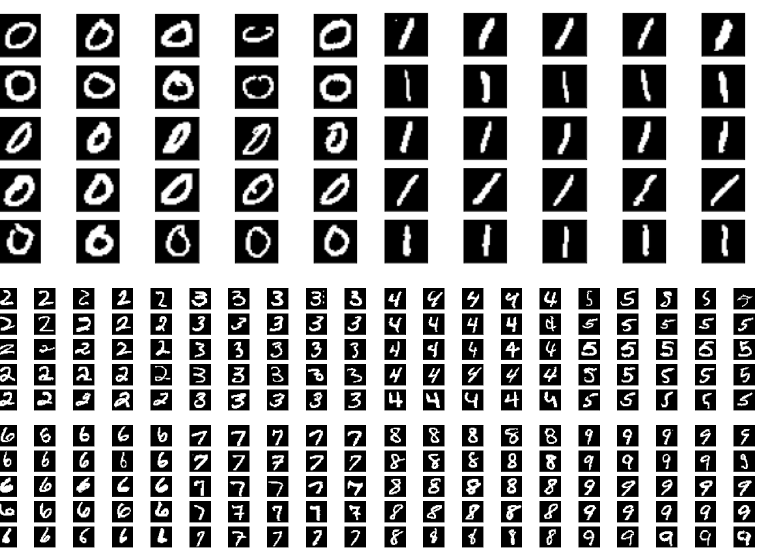
Figure 8. Clustering